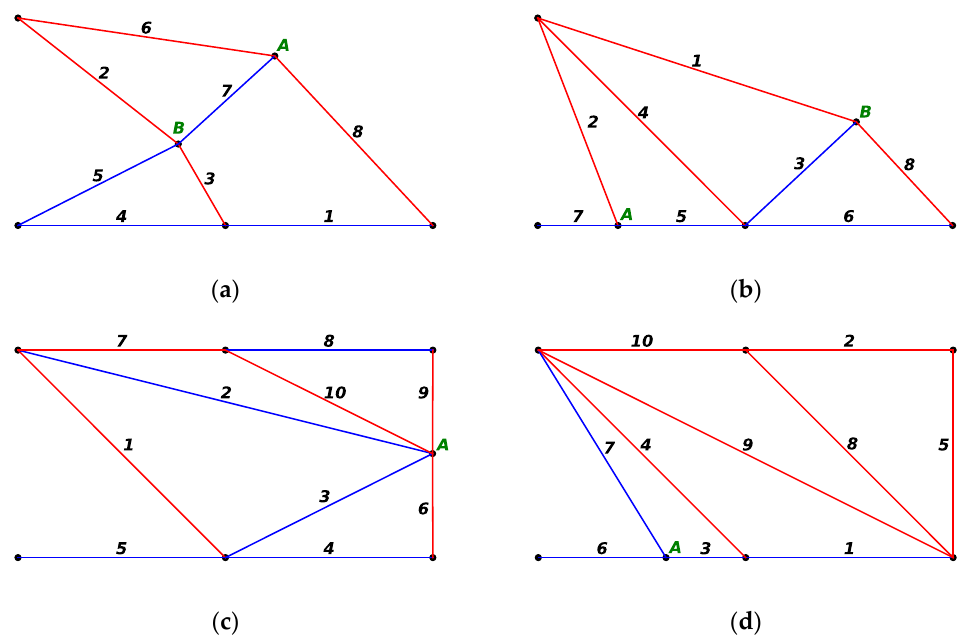
Figure 9. Generated trusses in experiment 2, color red and blue denote the compression and tension bar, respectively. ( a ) Load case I with constraint combination I; ( b ) Load case I with constraint combination II; ( c ) Load case II with constraint combination I; ( d ) Load case II with constraint combination II.